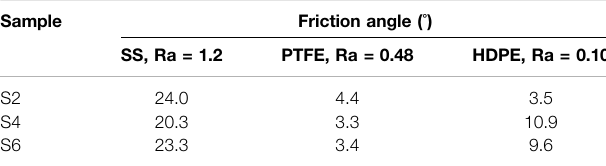
TABLE 4 | Effective friction angles in the FT4 for loblolly pine for different wall coupons. Sample